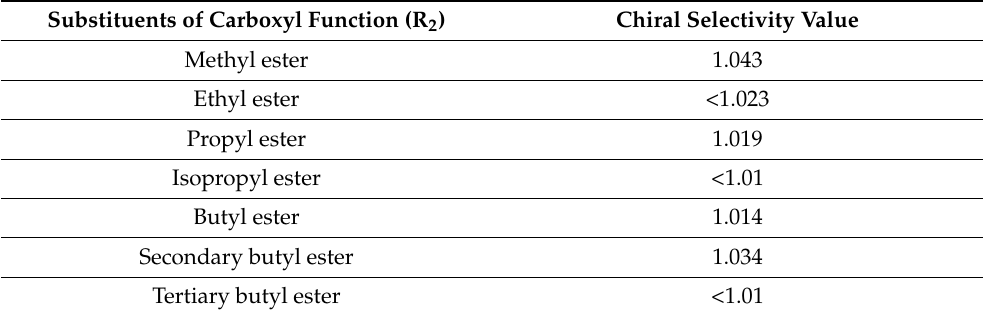
Table 2. The selectivity values of cis -permethrinic acids (R 2 : Cl) in various derivative forms on the Chirasil-Dex at 100 ◦